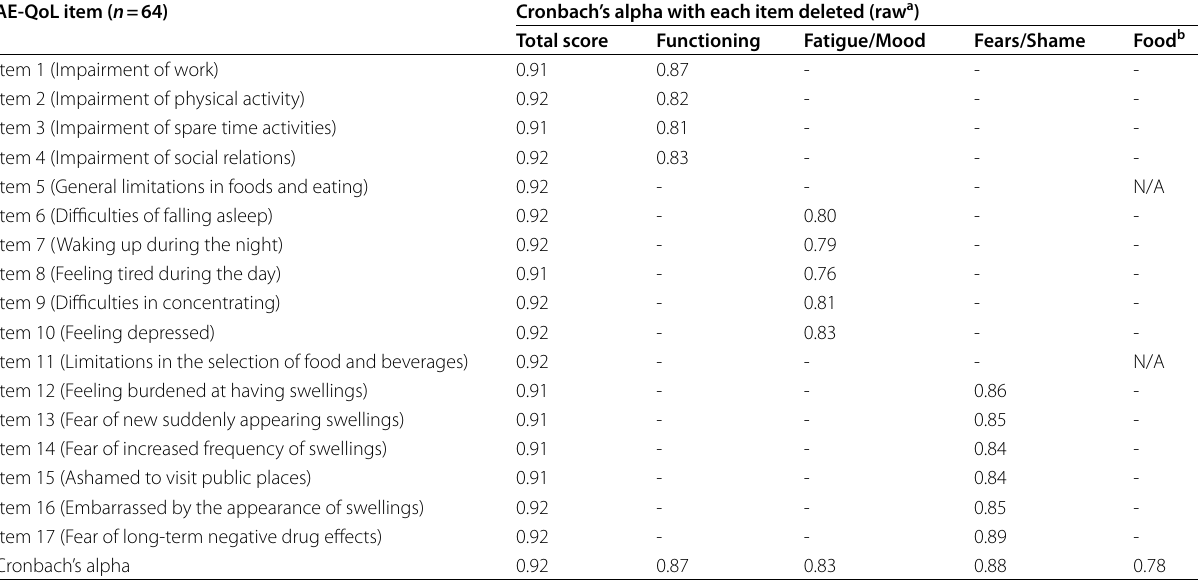
Table 3 Summary of Cronbach’s alpha with each item deleted for AE-QoL total and domain scores at baseline AE-QoL item ( n = 64)